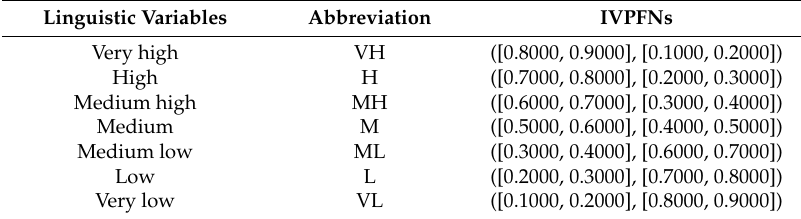
Table 1. Linguistic terms for rating the failure modes [50].